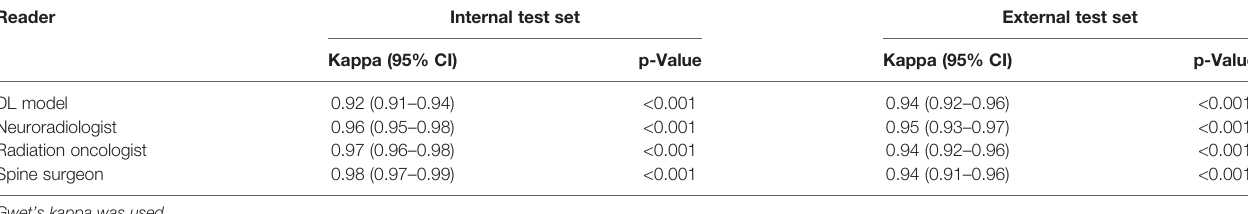
TABLE 3 | Internal and external test set classi fi cations using dichotomous Bilsky gradings (low versus high grade) on MRI. Reader